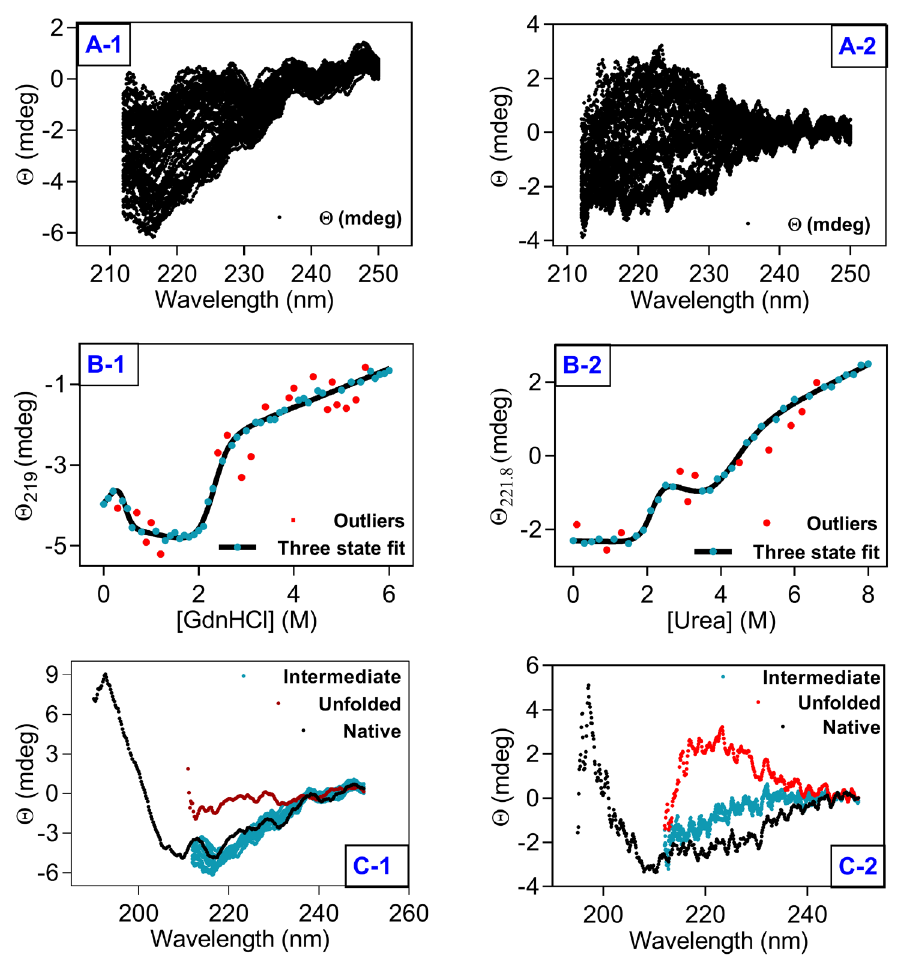
Figure 4. GuHCl/urea induced unfolding studies of human aldose reductase (hAR)monitored by far-UV circular dichroism (CD). ( A1 ) far-UV CD scans recorded for GuHCl and ( A2 ) far-UV CD scans recorded for urea for all the samples. ( B1 ) change in ellipticity at 219 nm against [GuHCl] and ( B2 ) change in ellipticity at 221.8 nm against [urea]. ( C ) CD spectra of samples in native (black), intermediate (cyan), and unfolded state (red) for ( C1 ) GuHCl and ( C2 ) urea, respectively. The solid lines represent curves fitted to the unfolding transitions; filled symbols represent data points from unfolding experiments; red symbols represent outliers in data fitting.